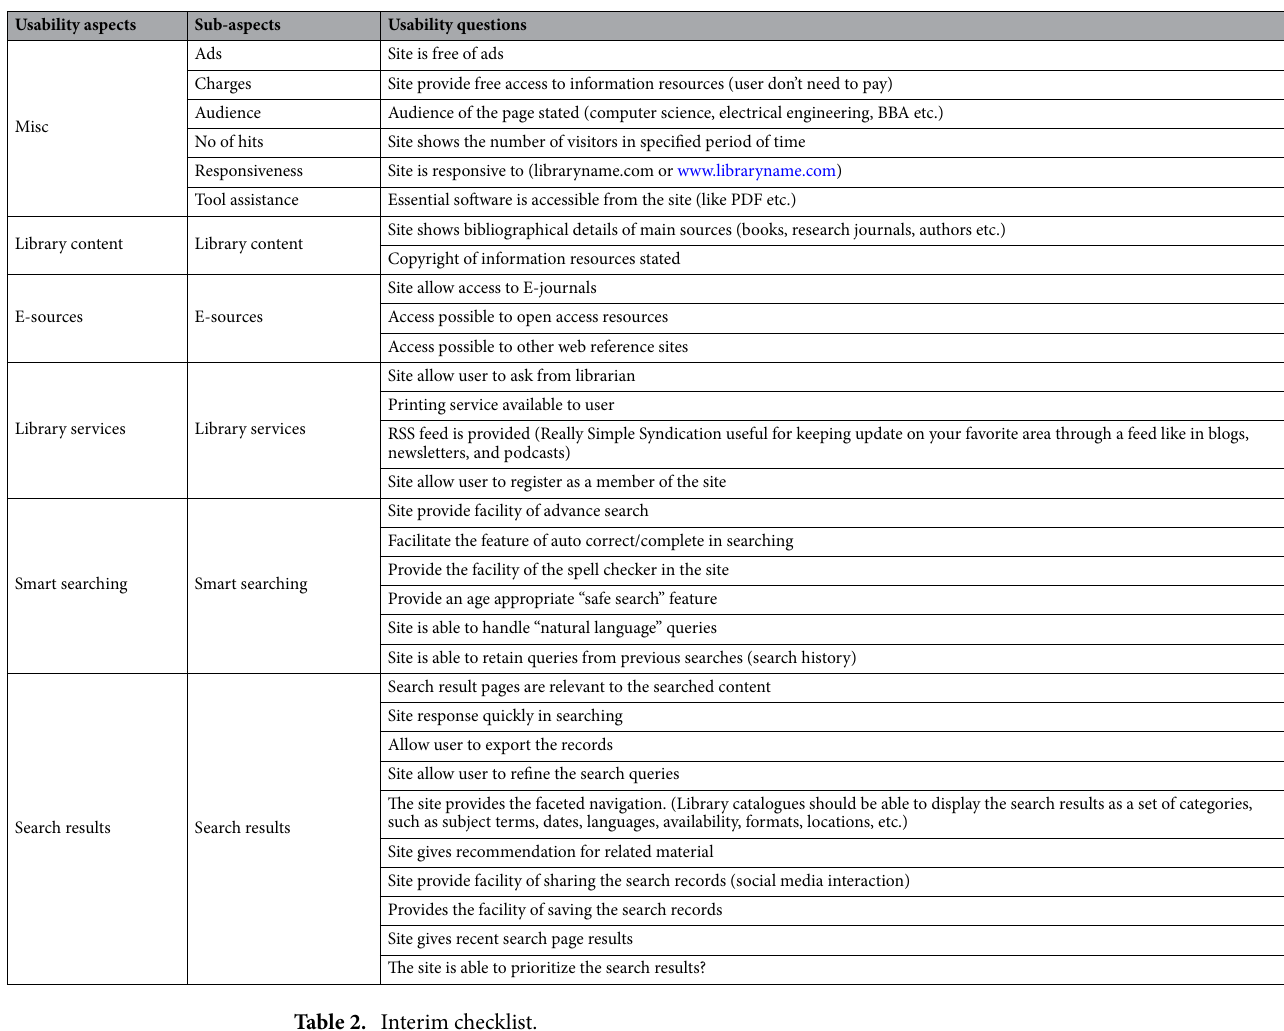
Table 2. Interim checklist.